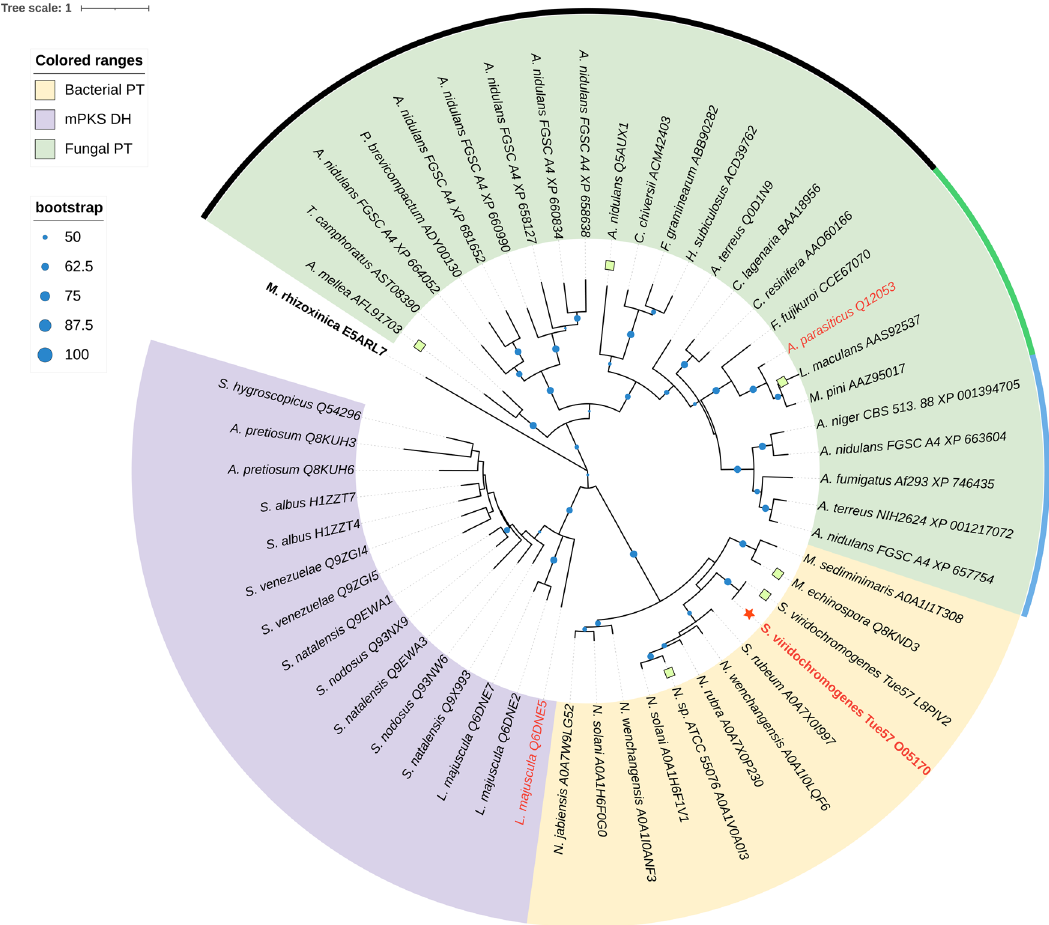
Fig. 6 Phylogenetic tree of bacterial PTs, mPKS DHs and fungal PTs. The color range of light yellow, light purple and pale green represent the bacterial PTs, modular type I PKS DHs and fungal PTs, respectively. The uncolored range node ( M. rhizoxinica E5ALR7) is the outgroup branching domain. The blue dot indicates the clustering with bootstrap value. Sequence of AviM PT is marked by red asterisk and labeled in red. PksA PT ( A. parasiticus Q12053) and CurF (L. majuscule Q6DNE5) are labeled in red. The black, green and dark purple circular represent fungal PTs with C2 – C7, C4 – C9, C6 – C11 cyclization speci fi